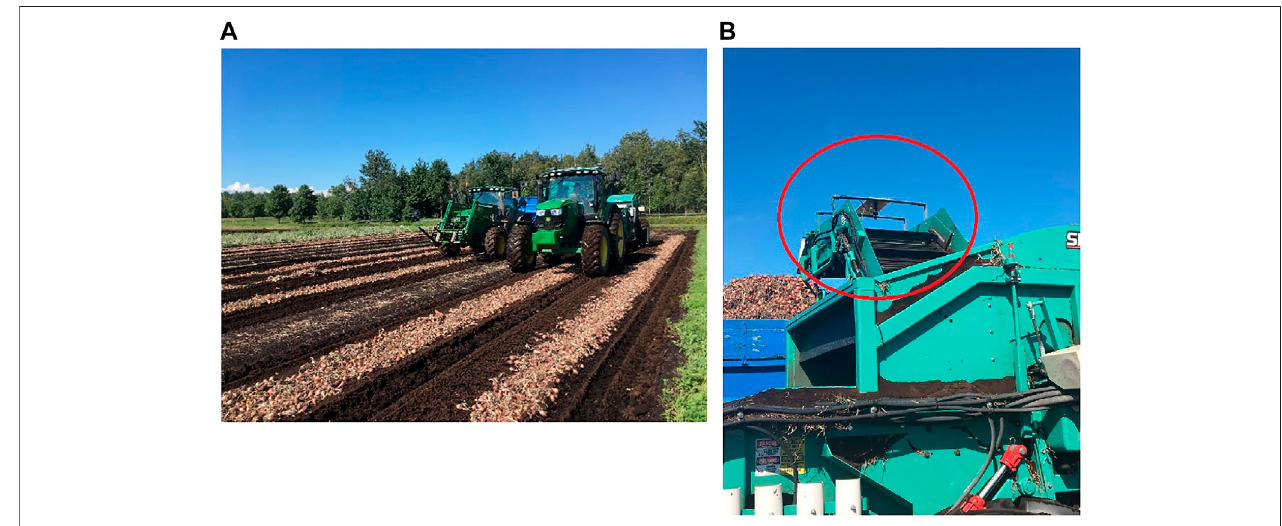
FIGURE 1 | Shallot onion fi eld (A) and machine vision bracket (encircled) (B)